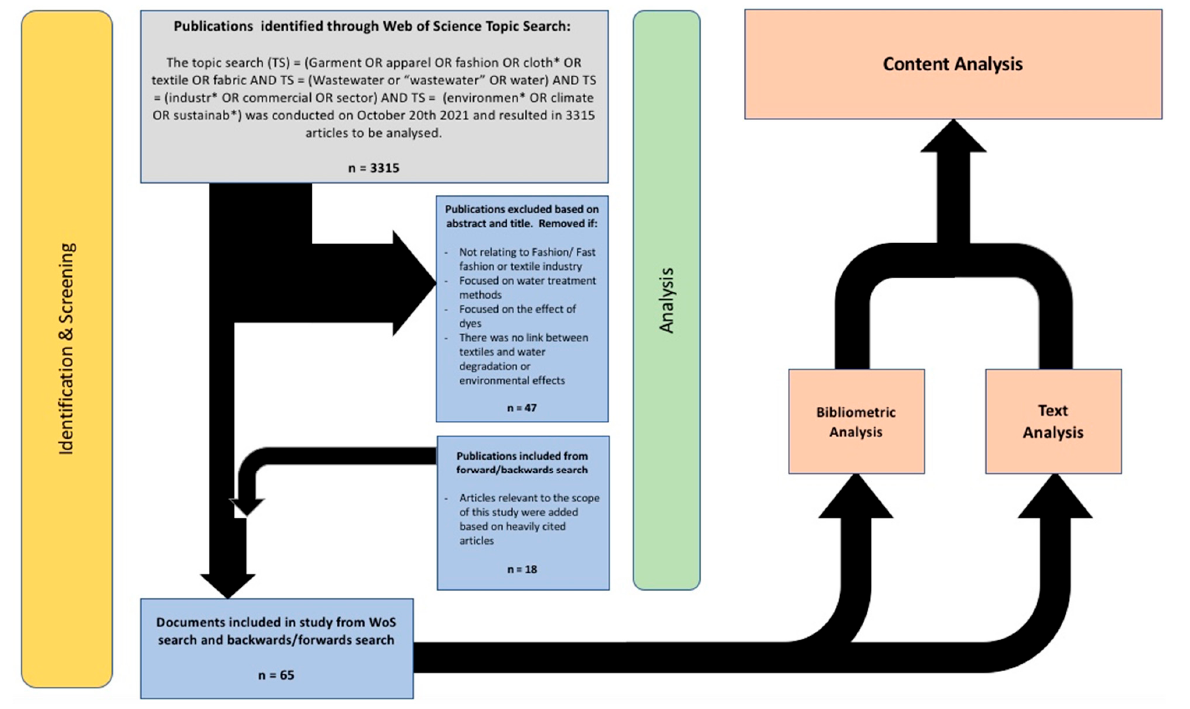
Figure 1. Flow chart summarising the systematic review process used in this study; this includes the search key for the identification of articles, exclusion criteria, supplemented studies, and subsequent bibliometric, text, and content analyses.